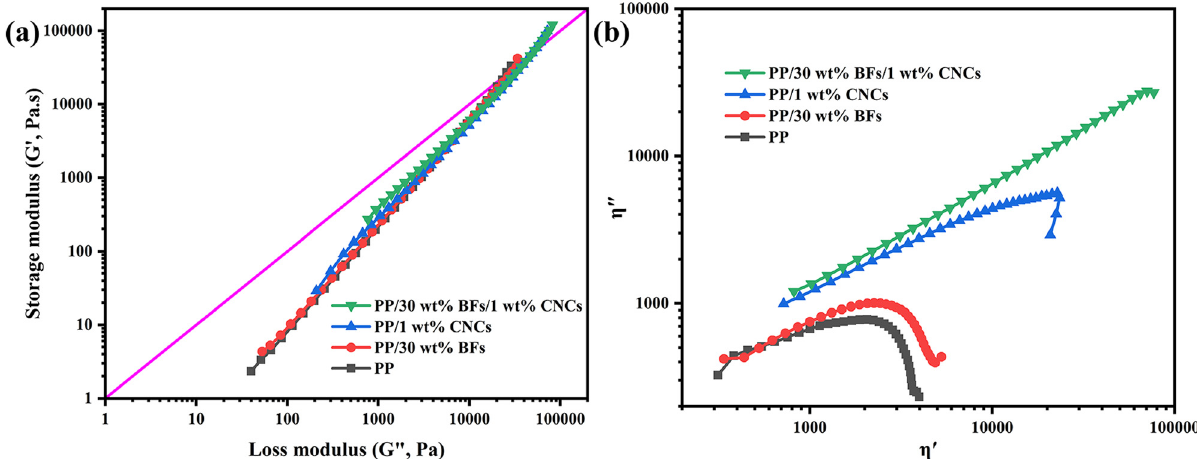
Figure 6: Comparison of Han curves and Cole – Cole curves of composites with di ff erent contents of CNCs and BFs from analyzing rheological behaviors: ( a ) Han curves and ( b ) Cole – Cole